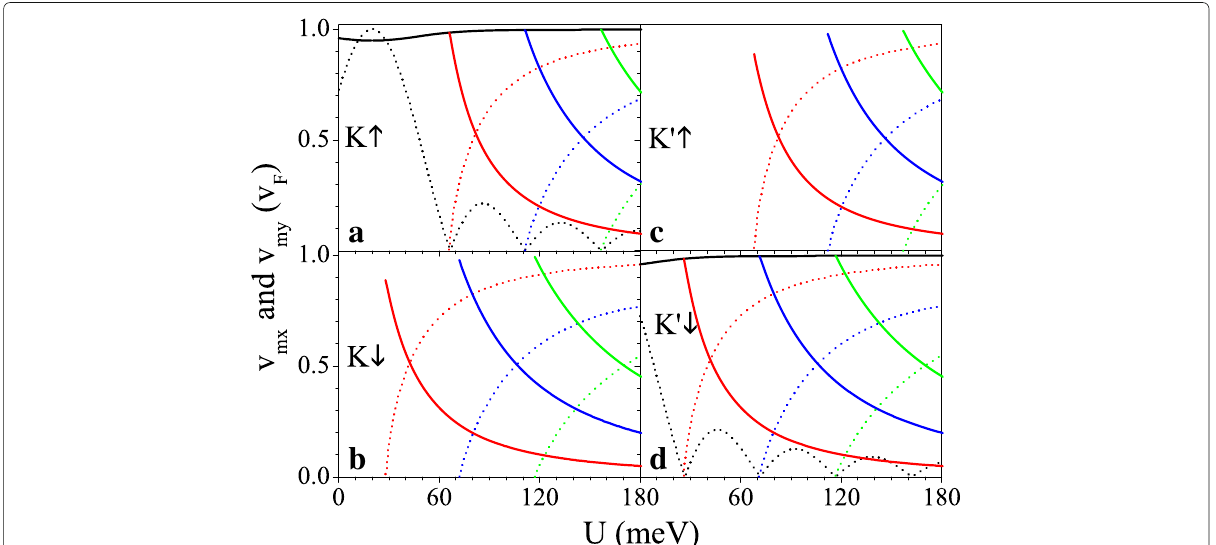
Fig. 5 ( a – d ) Velocity versus potential U , and the parameters are set as h = 20.0 meV and (cid:2) z = 7.8 meV. The black, red, blue, and green solid curves are the velocities v 0 x , v 1 x , v 2 x , and v 3 x , respectively. The black, red, blue, and green dashed curves are the velocities v 0 y , v 1 y , v 2 y , and v 3 y ,